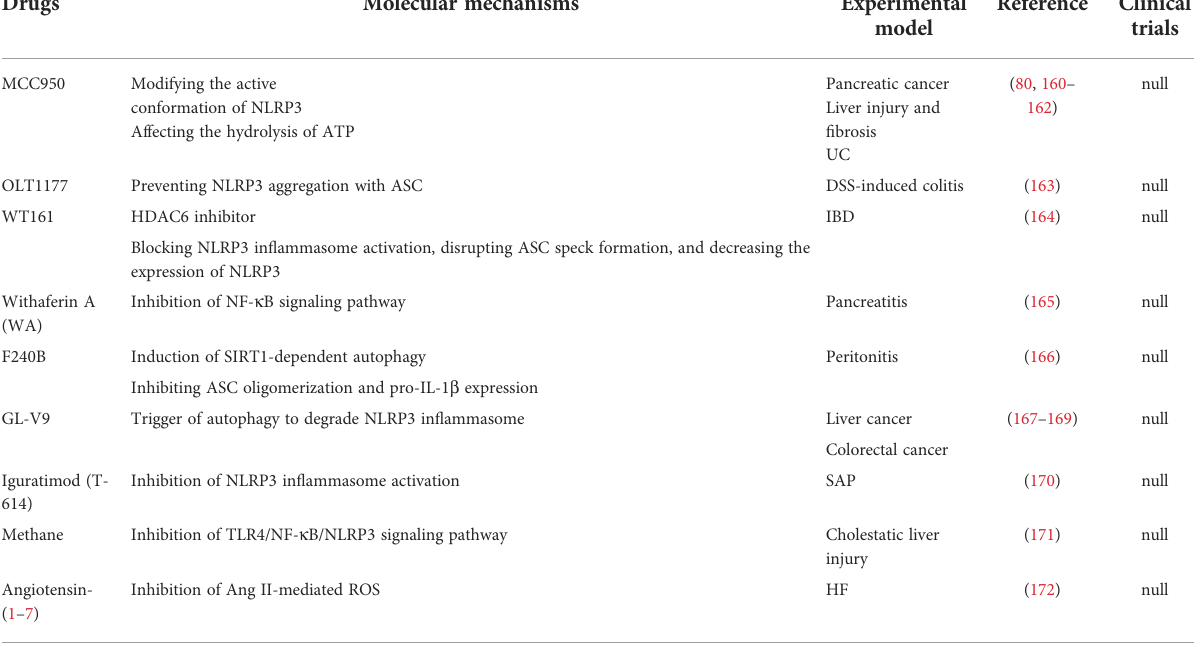
TABLE 1 Small ‐ molecule chemical drugs able to inhibit NLRP3 activation in animal models of digestive diseases.